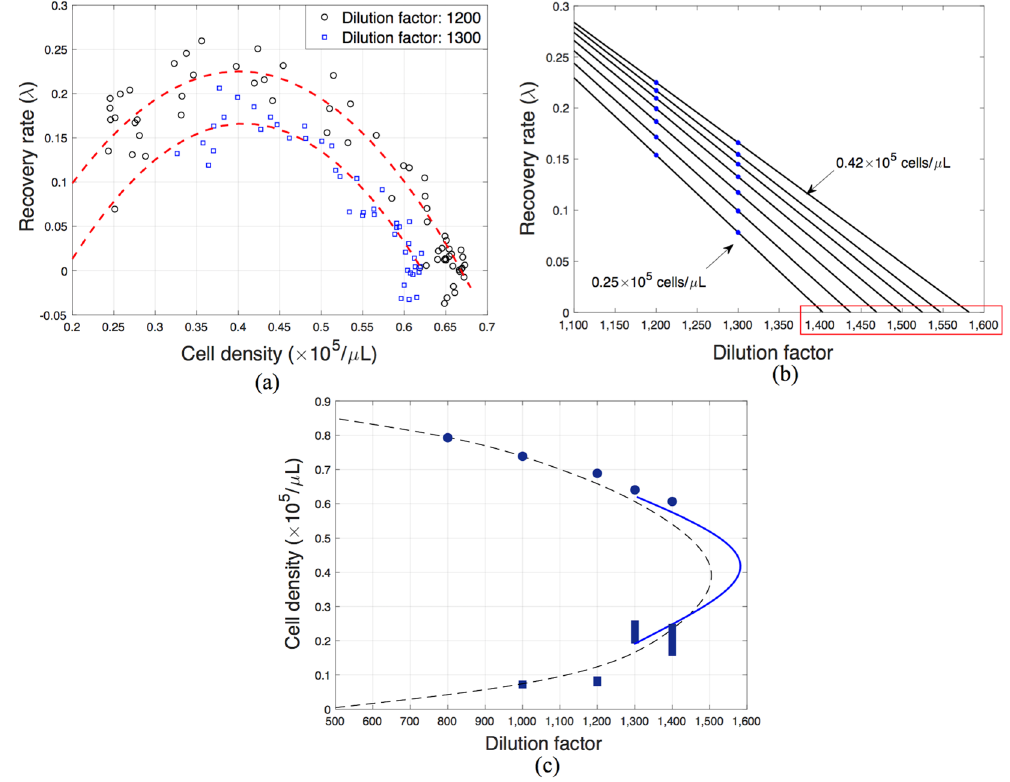
Figure 5. Forecasting using experimental measurements at dilution factors of 1,200 and 1,300, corresponding to case ( a ) shown in Fig. 2. ( a ) Recovery rates and quadratic polynomial fits at each amplitude estimated from the measurements shown in Fig. 5. ( b ) Example of extrapolated recovery rates at selected amplitudes to forecast the dilution factor at which the recovery rate is zero for each population density. ( c ) Forecasted bifurcation diagram (blue line). Circles and vertical bars represent experimentally approximated stable and unstable points on the bifurcation diagram, respectively. The dashed line is the approximated bifurcation diagram using the calibrated